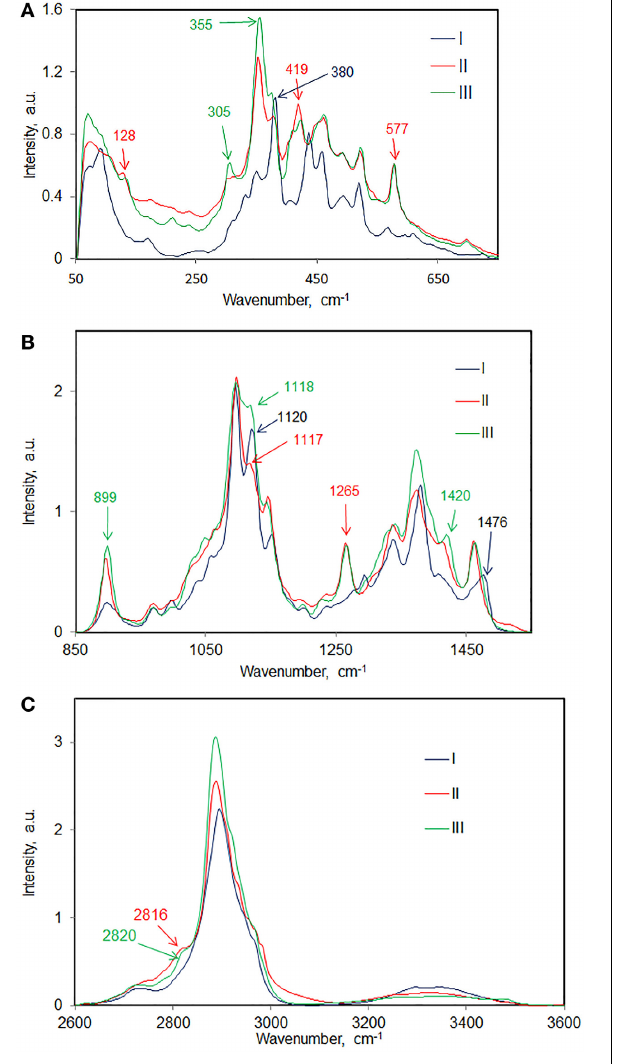
( Table 3 , Figure 7B ). The scissor mode bands at 1476 and 1461 cm − 1 have been assigned to tg and gg conformers of the CH 2 OH group ( Figure 8 ; Agarwal and Ralph, 2014). This indi- cated that in avicel I cellulose structure has both tg and gg CH 2 OH conformers whereas avicel II and avicel III have only the gg conformer. In the rest of the Raman region below 1400 cm − 1 , there are at least four sets of bands that are only detected in cellulose avicel II and avicel III I and not in avicel I. These are located at ∼ 1265, ∼ 697, ∼ 577, and ∼ 420 cm − 1 . Moreover, there are bands whose frequencies are similar to that of avicel I but the band-profiles are different (e.g., 1120 cm − 1 , Figure 7B ). The aforementioned seems to suggest that avicel II and avicel III I structures may be similar because the band positions and pro- files of a number of bands are similar. However, further analysis